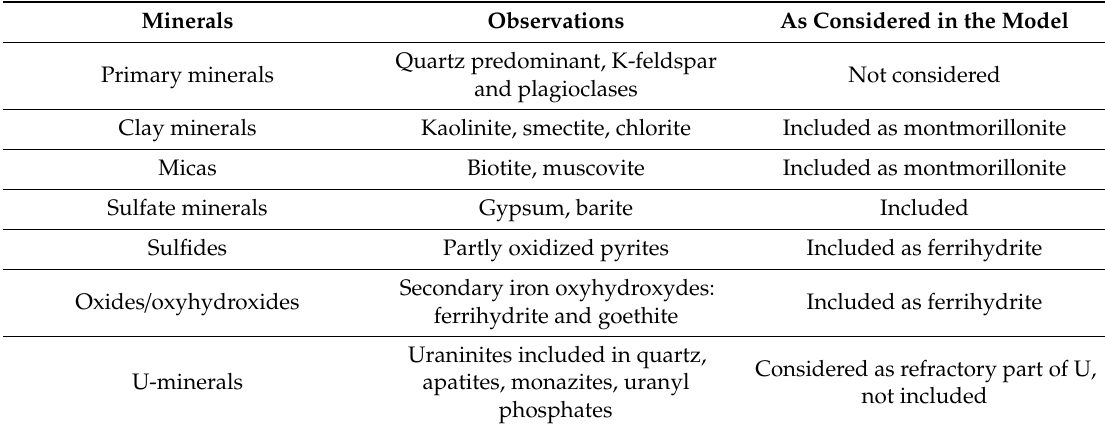
Table 2. Minerals observed in the clayey silty samples, determined by X-ray di ff raction (XRD) and confirmed by Scanning Electron Microscopy / Energy Dispersive X-ray Spectroscopy (SEM / EDS), and the phases considered in the